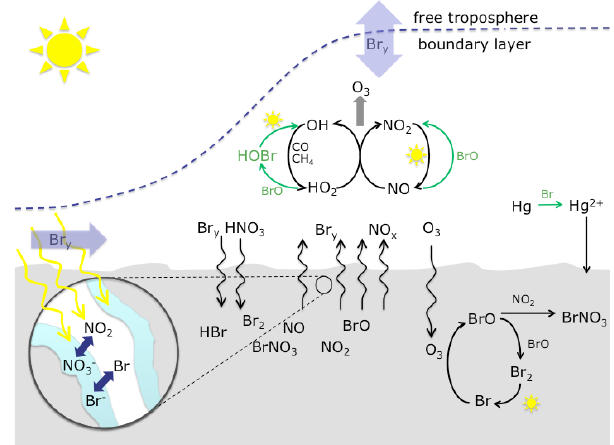
Fig. 1. Sketch of the local processes influencing chemistry of NO x , HO x , and reactive bromine over snow. Atmospheric reactions show the basic HO x and NO x cycles, which ultimately lead to the formation of ozone, as well as the impact of bromine chemistry on these cycles and elemental mercury. The figure illustrates the poorly constrained photochemical source of reactive nitrogen and bromine compounds in the liquid layer on snow crystals and the exchange of trace species between the snow and the atmosphere, which is tied to vertical transport processes. The composition of interstitial air and its gas-phase chemistry has not been well quantified. For example, if present, bromine compounds in the interstitial air would be expected to deplete ozone and react with nitrogen oxides to form bromine nitrate..